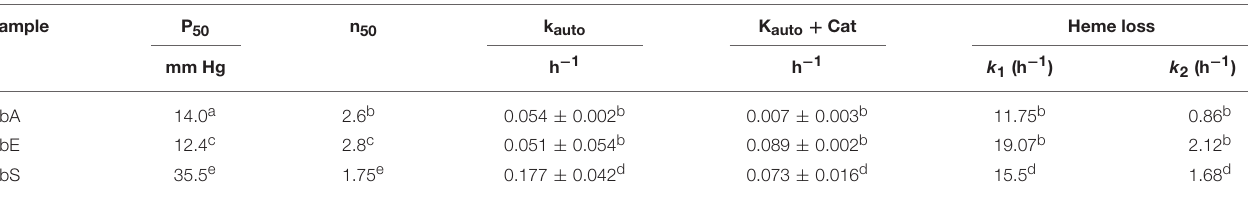
TABLE 1 | Oxygen equilibrium parameters, autooxidation and heme loss kinetics of mutant hemoglobins (HbE and HbS) contrasted with values for normal human hemoglobin.